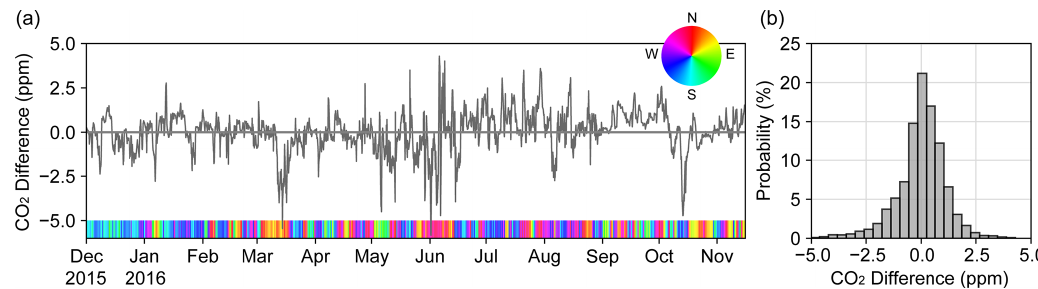
Figure 13. (a) Time series and (b) distribution of all hourly CO 2 concentration differences between BEP_MYJ and BEP_MYJ_CT using CAMS and CarbonTracker as CO 2 boundary conditions respectively. This comparison is based on the simulated values in the 25km grid cell of the outermost domain (D01) containing the city of